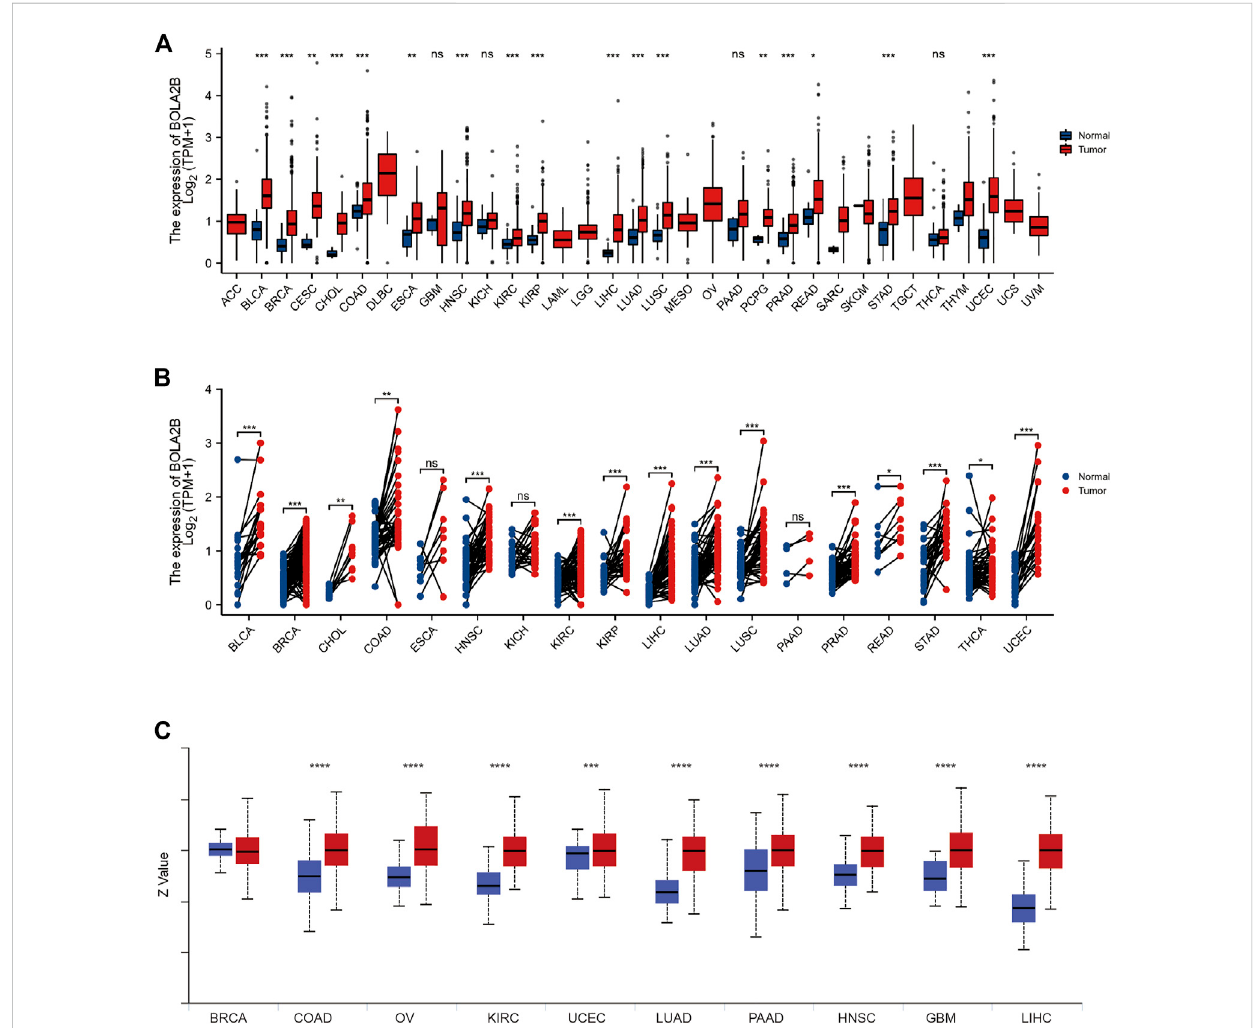
FIGURE 1 High expression of BOLA2B in cancers. (A) The mRNA expression of BOLA2B across 33 cancer types from TCGA data. (B) The mRNA expression difference from paired cancer and para-cancer in 18 cancer types. (C) The protein expression of BOLA2B from the CPTAC dataset. Red color represents the tumor sample, and blue color refers to normal samples. * p < 0.05, ** p < 0.01, and *** p <